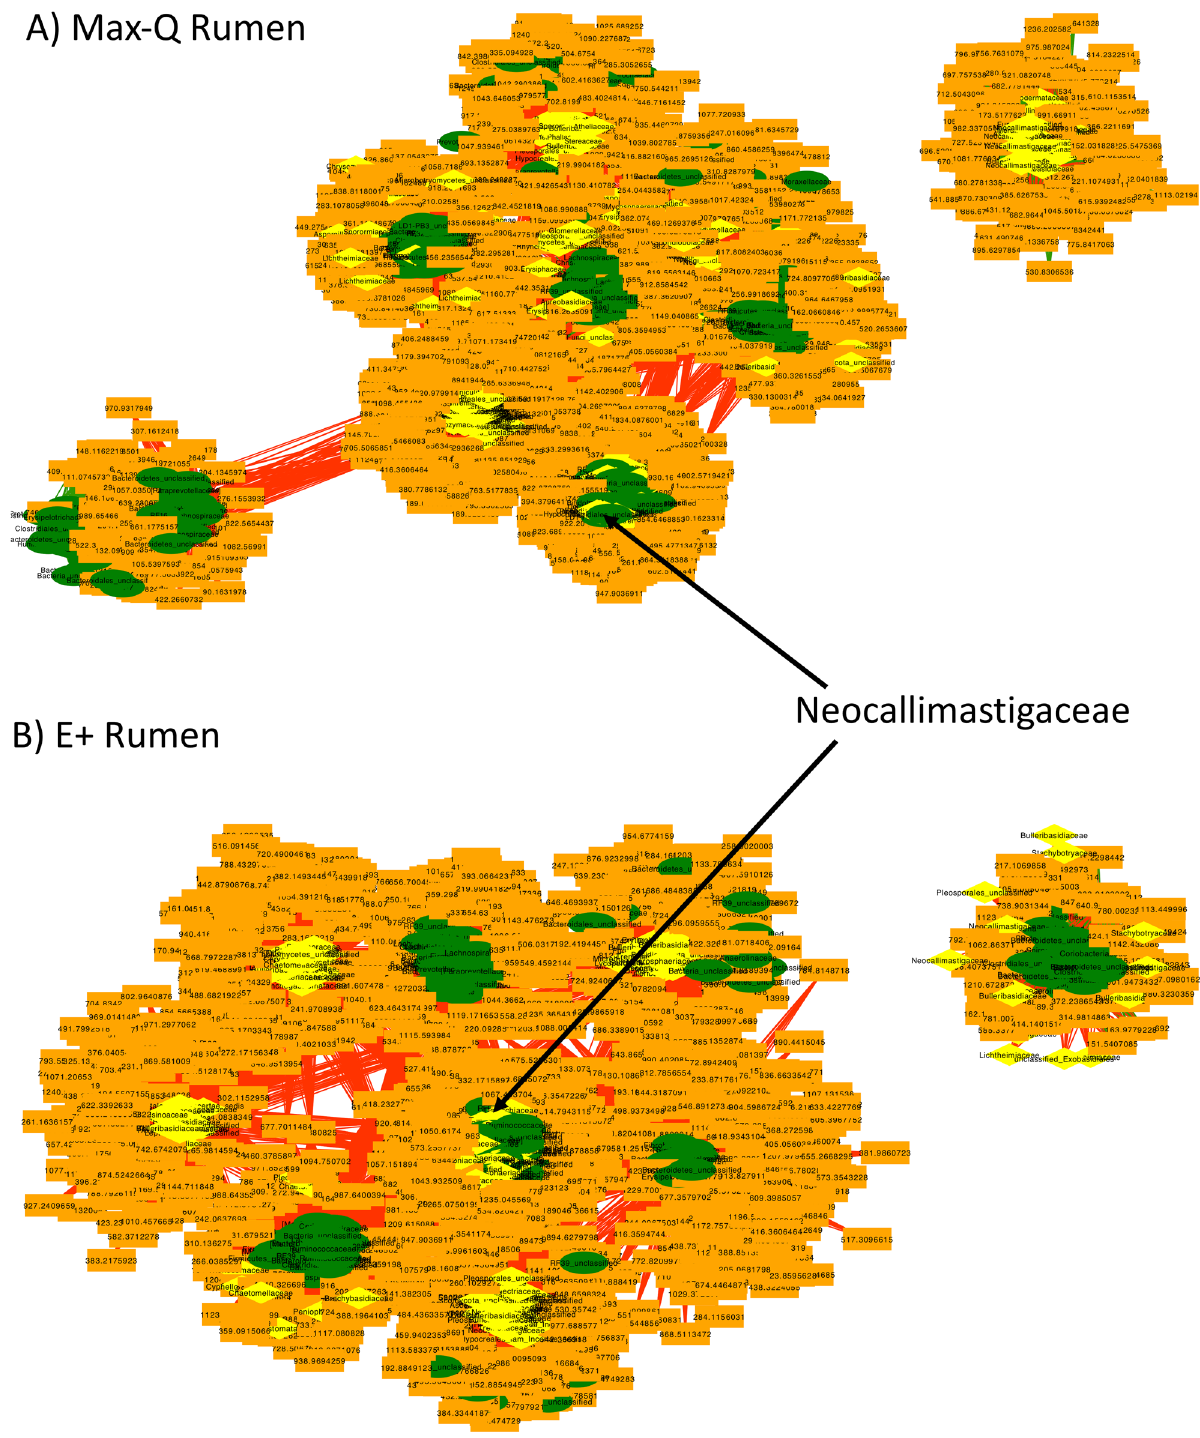
Figure 7. Global rumen integrative interactomics networks demonstrating relationships between bacterial (green, oval) and fungal (yellow, diamond) OTUs and metabolites (orange, rectangle) of non-toxic ( A ; Max-Q; n = 6) or toxic ( B ; E+; n = 6) grazing beef steers. Green and red edges indicate positive and negative correlations, respectively. Select nodes of interest are highlighted by arrows and